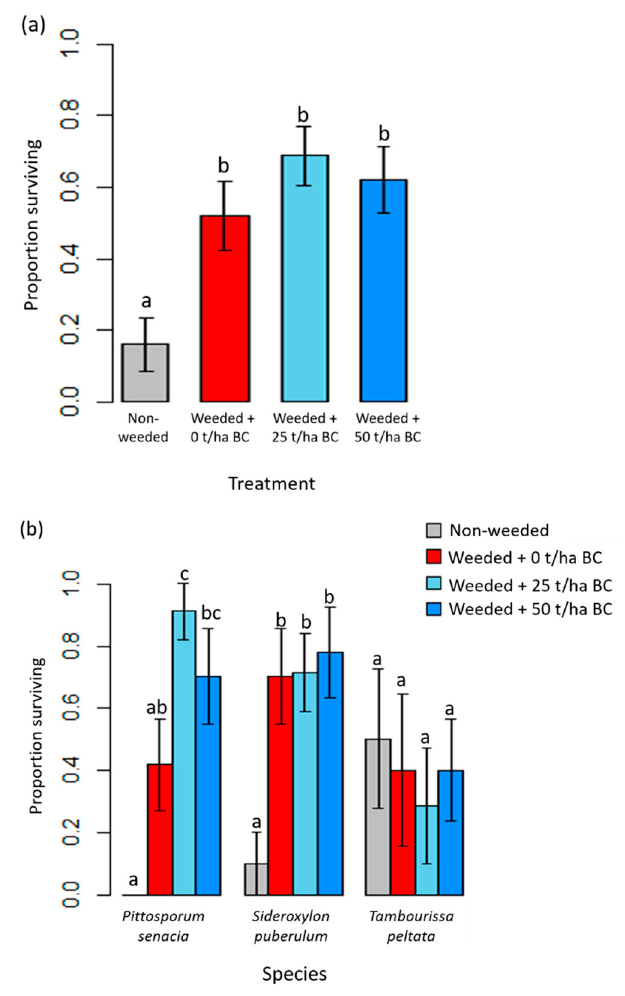
Figure 3. Proportion of native seedling survivorship after 30 months by treatment: ( a ) pooled data; ( b ) by species for P. senacia , S. puberulum , and T. peltata . Weeding (strawberry guava removal) and biochar treatments at rates of 0, 25, and 50 t/ha are compared to the non-weeded control. Means are plotted as ±1 SE; differences significant at p < 0.05 (Tukey HSD post hoc tests) are indicated by different letters.